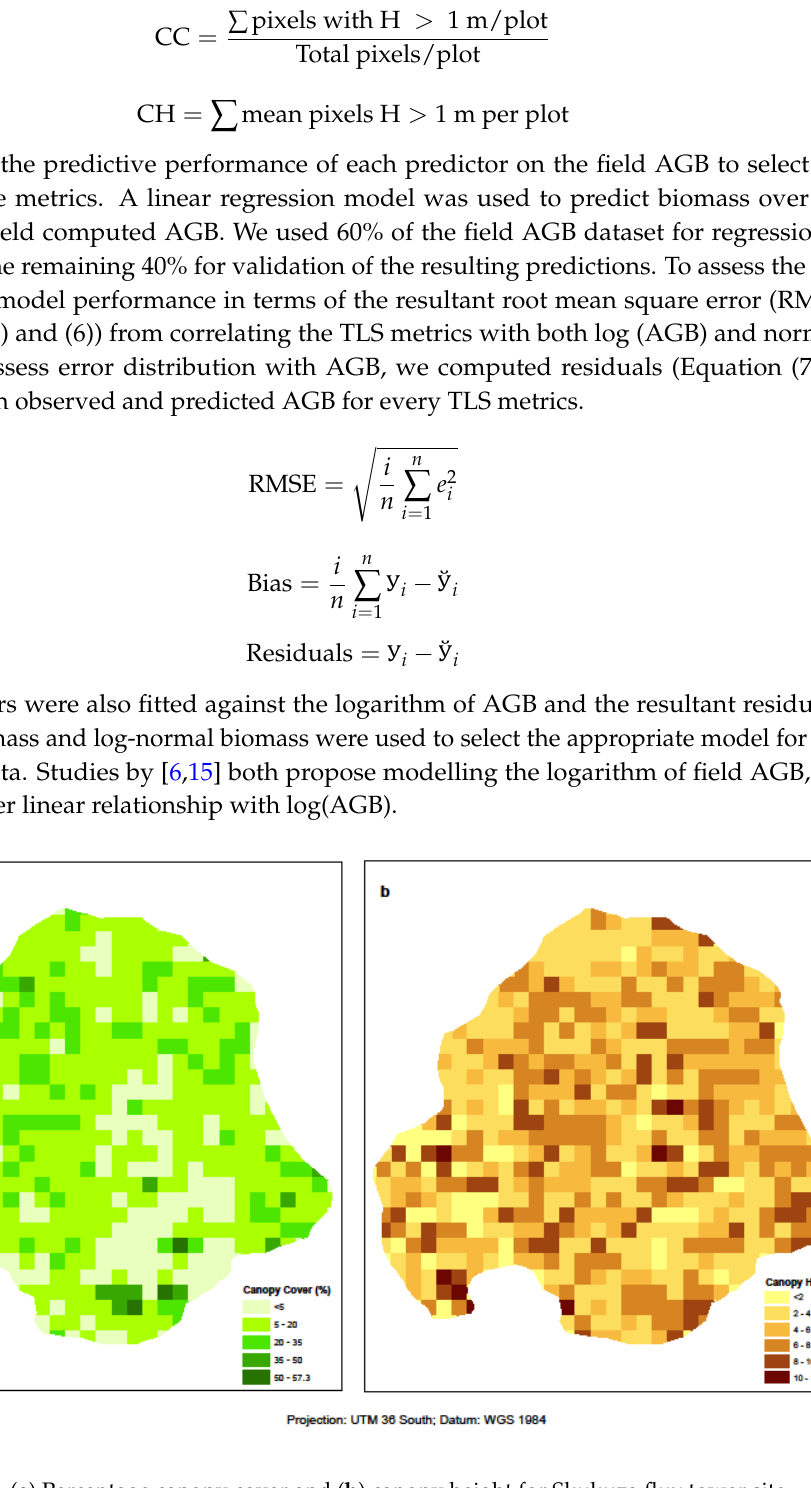
Figure 5. ( a ) Percentage canopy cover and ( b ) canopy height for Skukuza flux tower site.